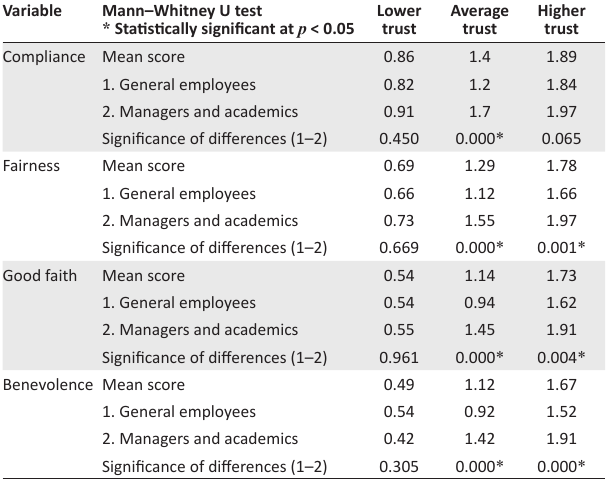
TABLE 3: Perceived compliance, fairness, good faith and benevolence levels: Employment groups. Variable Mann–Whitney U test * Statistically significant at p < 0.05